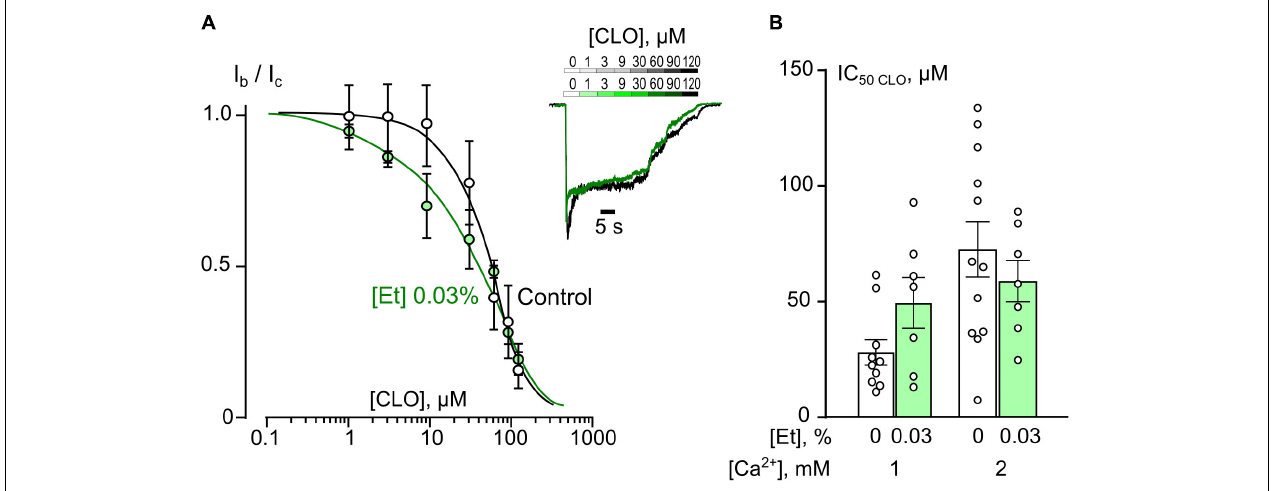
FIGURE 3 | Ethanol do not affect inhibition of NMDAR currents by clomipramine (CLO). (A) Concentration-inhibition curves for CLO inhibition of currents activated by 100 µ M NMDA + 30 µ M Gly obtained in 2 mM [Ca 2 + ] in the control bathing solution or in ∼ 6 mM ethanol ([Et] 0.03%). Symbols show mean values ± SEM of the relative amplitudes of currents (I b /I c ) in the presence (I b ) and absence (I c ) of different CLO concentrations ([CLO]). In insert sample traces of NMDAR currents normalized to the steady-state amplitude without CLO, recorded at –70 mV in the presence of increasing CLO concentrations in control (upper row) and in ethanol (lower row) are shown. (B) Dependence of IC 50 for inhibition of NMDAR currents by CLO on extracellular [Ca 2 + ] and ethanol obtained from experiments illustrated in (A) . Data from each experiment (symbols) and mean values ± SEM are shown. Mean IC 50 values are summarized in Table 1 . Two-way ANOVA ([Ca 2 + ] × [Et]) show no significant effects for both [Et] and [Ca 2 + ]. Data obtained in ethanol and without ethanol do not differ significantly in both 1 and 2 mM [Ca 2 +